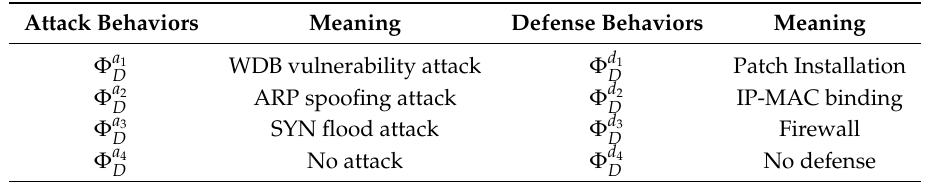
Table 2. Attack–defense behaviors in the penetration